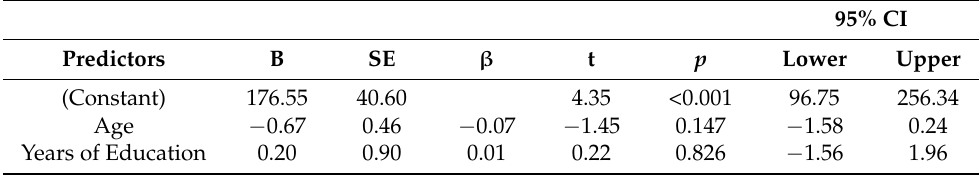
Table 6. Ordinary Least Squares Coefficients Table of Variables Retained by the